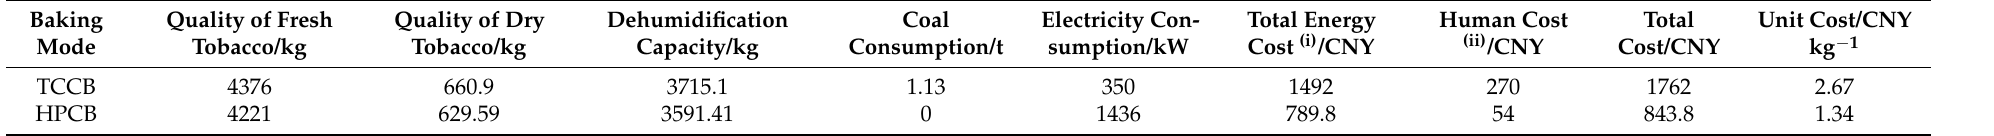
Table 9. Costs for the whole process of the two modes.